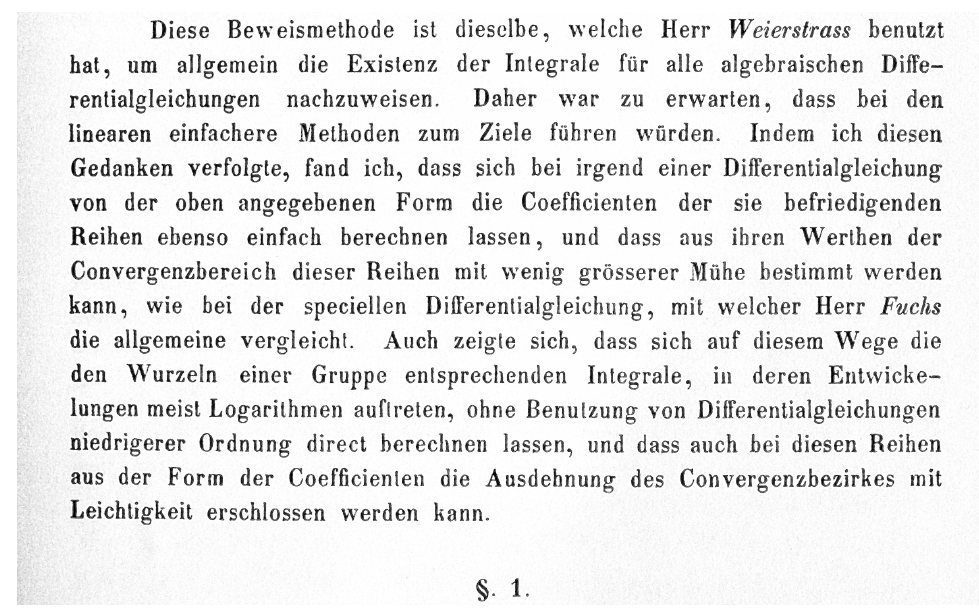
Figure 3. Closing paragraph of the opening section of Frobenius’ seminal paper on series solutions [6]. While paying due respect to the earlier works of Weierstrass and Fuchs, Frobenius explained that he believed his own approach offered a worthwhile alternative, because of its simplicity (“ ...